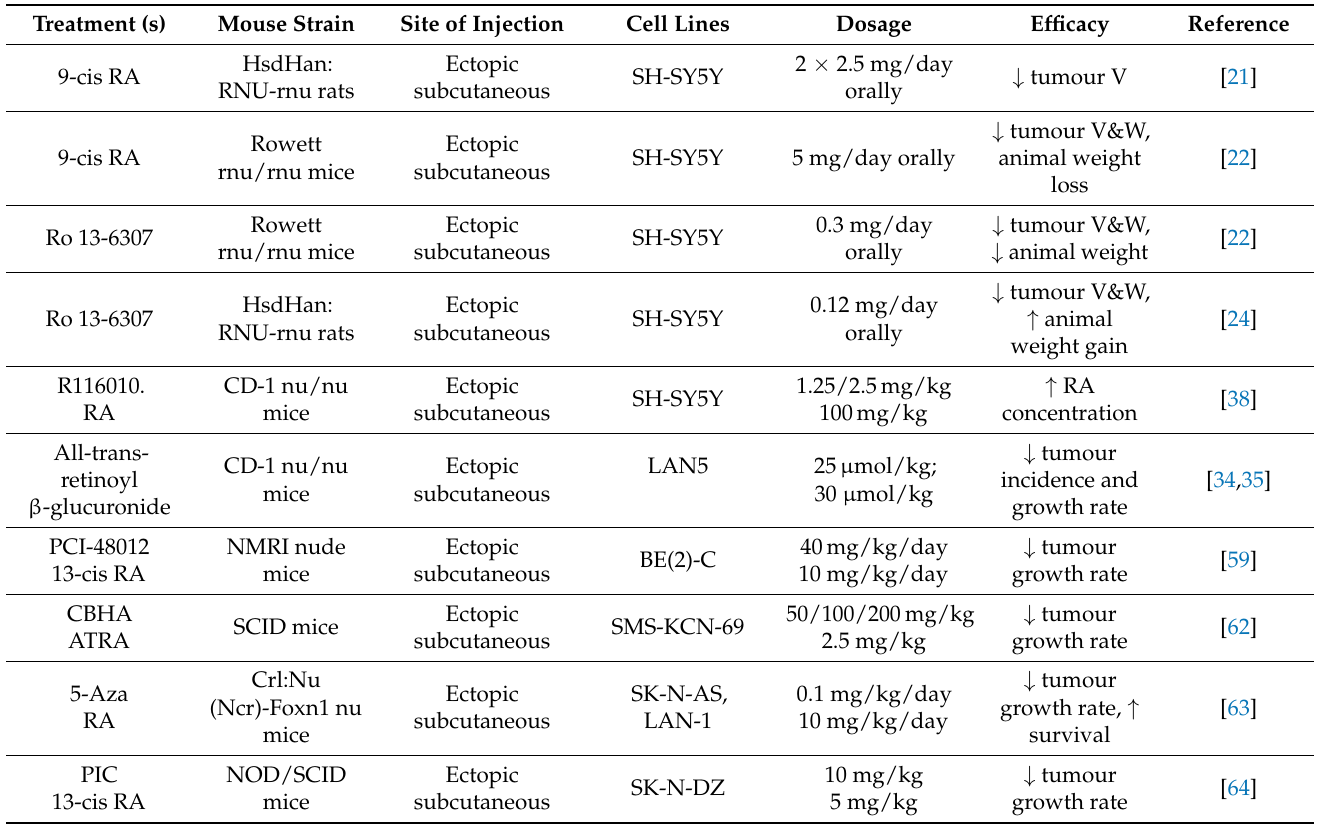
Table 4. Murine models used for RA